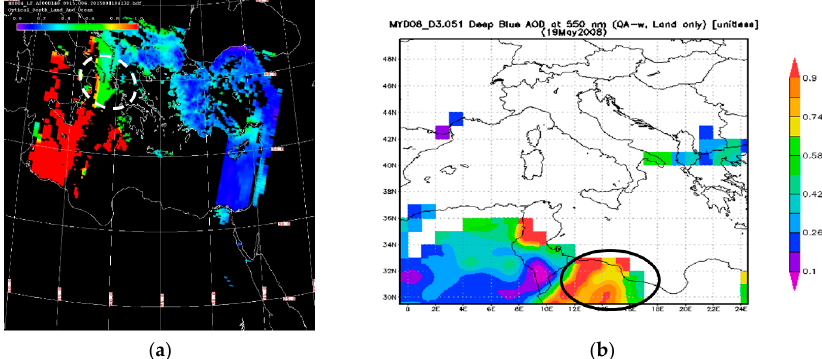
Figure 3. ( a ) Terra-MODIS AOD at the 550 nm product (Level-2) of 19 May 2008 at 09:15 UTC; ( b ) Deep Blue MODIS AOD at the 550 nm product of the same day. The white ellipse in the left panel and black ellipse in the right panel indicate two different regions characterized by medium-high values of AOD, which were considered as affected by dust in Figure 2b.